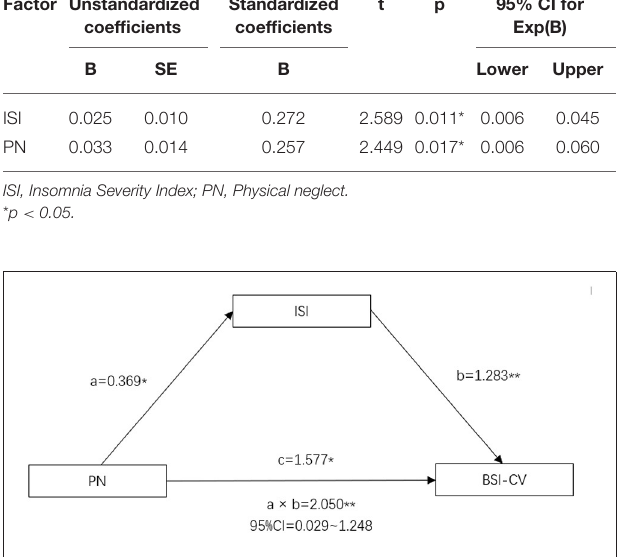
FIGURE 1 | Intermediate model of PN, insomnia and suicidal ideation in schizophrenia patients (* p < 0.05; ** p < 0.01). Path a is an independent variable (X) → mediator (M). Path b is mediator (M) → suicidal ideation (Y), adjusted for X. Path c is X → suicidal ideation (Y), adjusted for M. * p < 0.05. ** p < 0.01. PN, Physical Neglect; ISI, Insomnia Severity Index; BSI-CV, The Beck Scale for Suicide